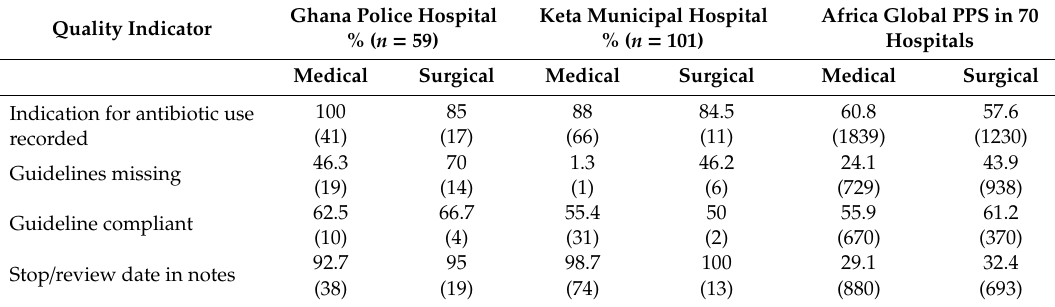
Table 2. Quality indicators for antibiotic use in Ghana hospitals compared with Africa data from Global